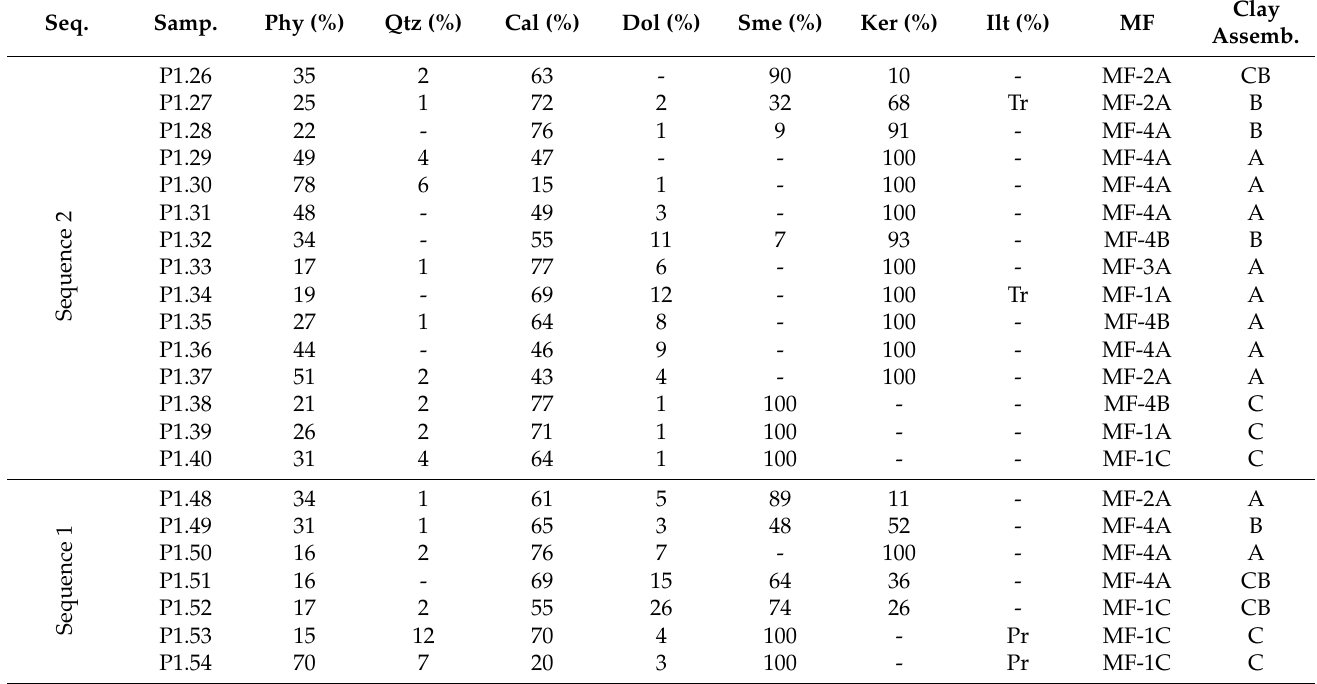
Table 1. XRD determinations of minerals for bulk and clay fraction (<2 µ m) samples, interpreted microfacies (MF) and clay assemblages, representatives of the identified mineralogical sequences intervals. Abbreviations: Phy (Phyllosilicate), Qtz (Quartz), Cal (Calcite), Dol (dolomite),